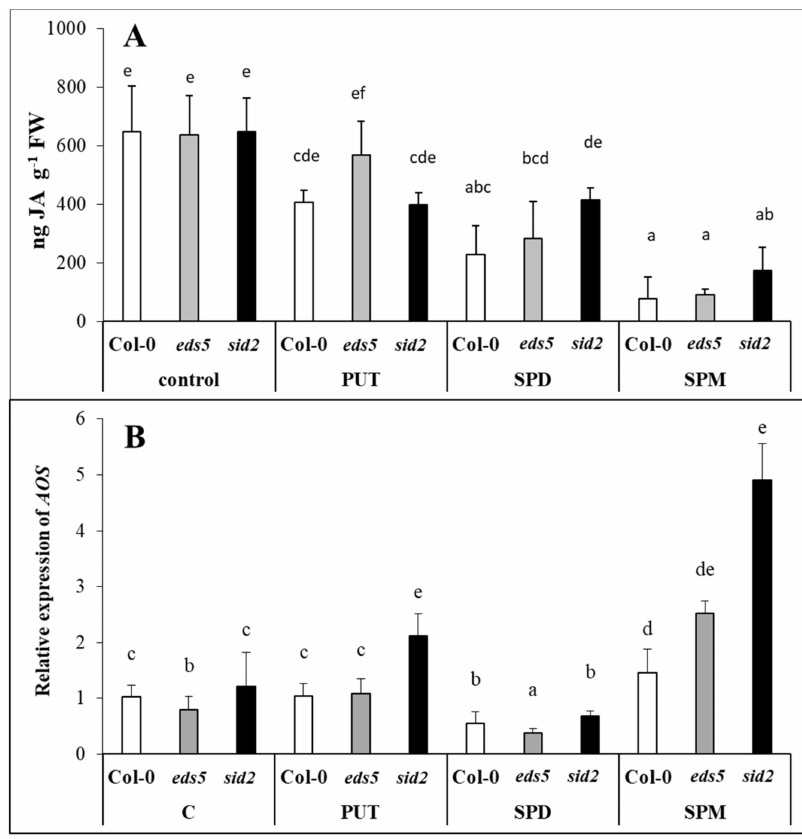
Figure 9. E ff ect of 0.5 mM 1-day of putrescine (PUT), spermidine (SPD) and spermine (SPM) treatments on the content of jasmonic acid (( A ) JA) and the expression level of gene involved in jasmonic acid synthesis (( B ) AOS: allene oxide synthase) in Col-0, wild type, eds5-1 ( eds5 ) and sid2-2 ( sid2 ) Arabidopsis mutants. Data represent mean values ± SD. Di ff erent letters indicate significant di ff erences at p ≤ 0.05